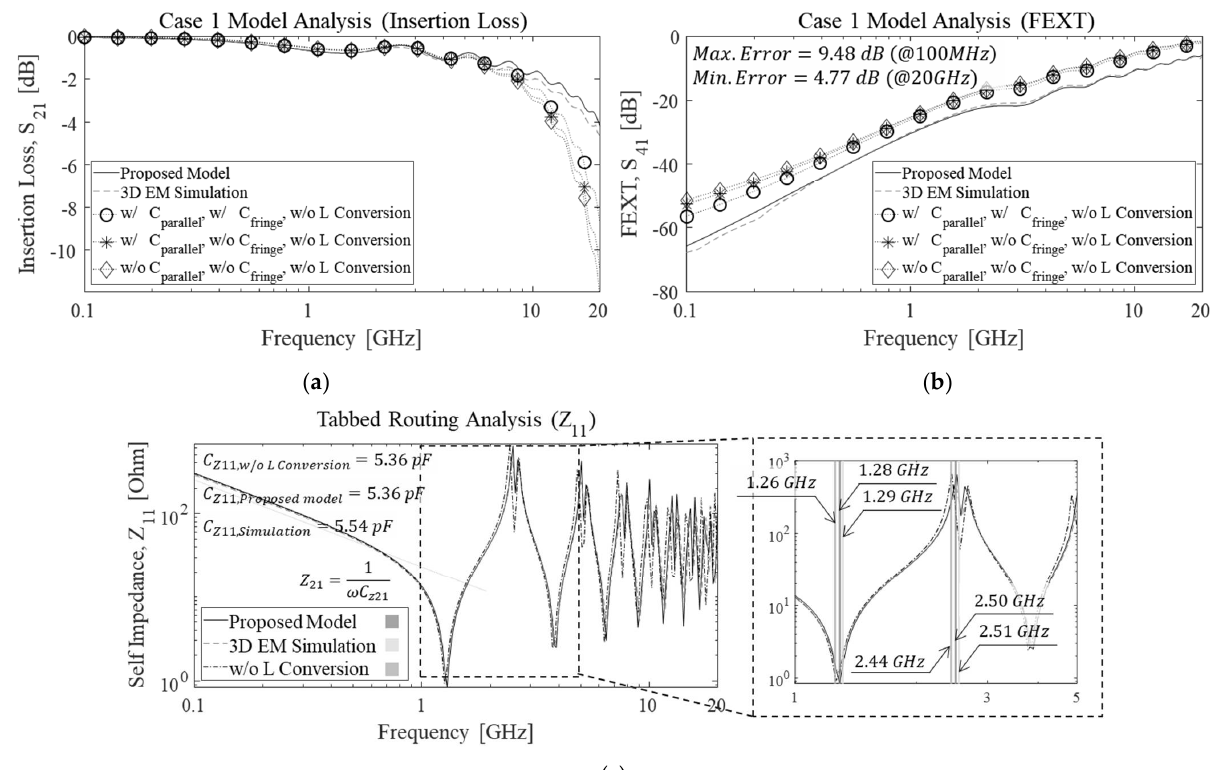
Figure 9. Frequency domain analysis of the proposed model with or without C parallel , C fringe , and L conversion for comparison of ( a ) insertion loss, ( b ) FEXT, and ( c ) self-impedance, Z 11 . For insertion loss and FEXT, five of the results with or without C parallel , and with or without C fringe , are compared in each graph. For the self-impedance graph, three different results, namely, those of the 3D EM simulation, the proposed model, and the model without L conversion, are shown and compared in the same plot.